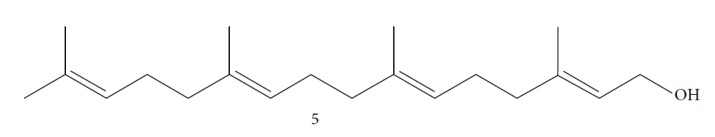
Chemical structure of geranylgeraniol, one of the main components of the ethanolic extract of Pterodon pubescens seeds.